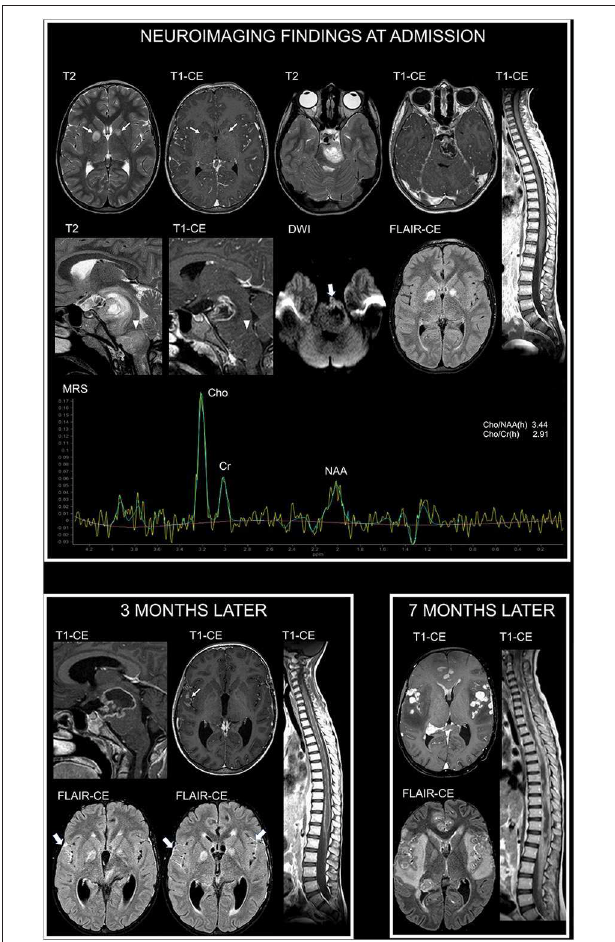
FIGURE 1 | Neuroimaging findings in NF1 patient 1. At admission, brain axial T2-weighted and contrast-enhanced (CE) T1-weighted images show focal areas of signal abnormalities without contrast enhancement in the globus pallidus bilaterally, in keeping with typical unidentified bright objects (thin arrows). Additional brain axial and sagittal T2-weighted and CE T1-weighted images show mass lesions with a central necrotic area and irregular rim enhancement in the left ponto-mesencephalic region, along with (arrowheads) an adjacent expansile lesion involving the medulla without